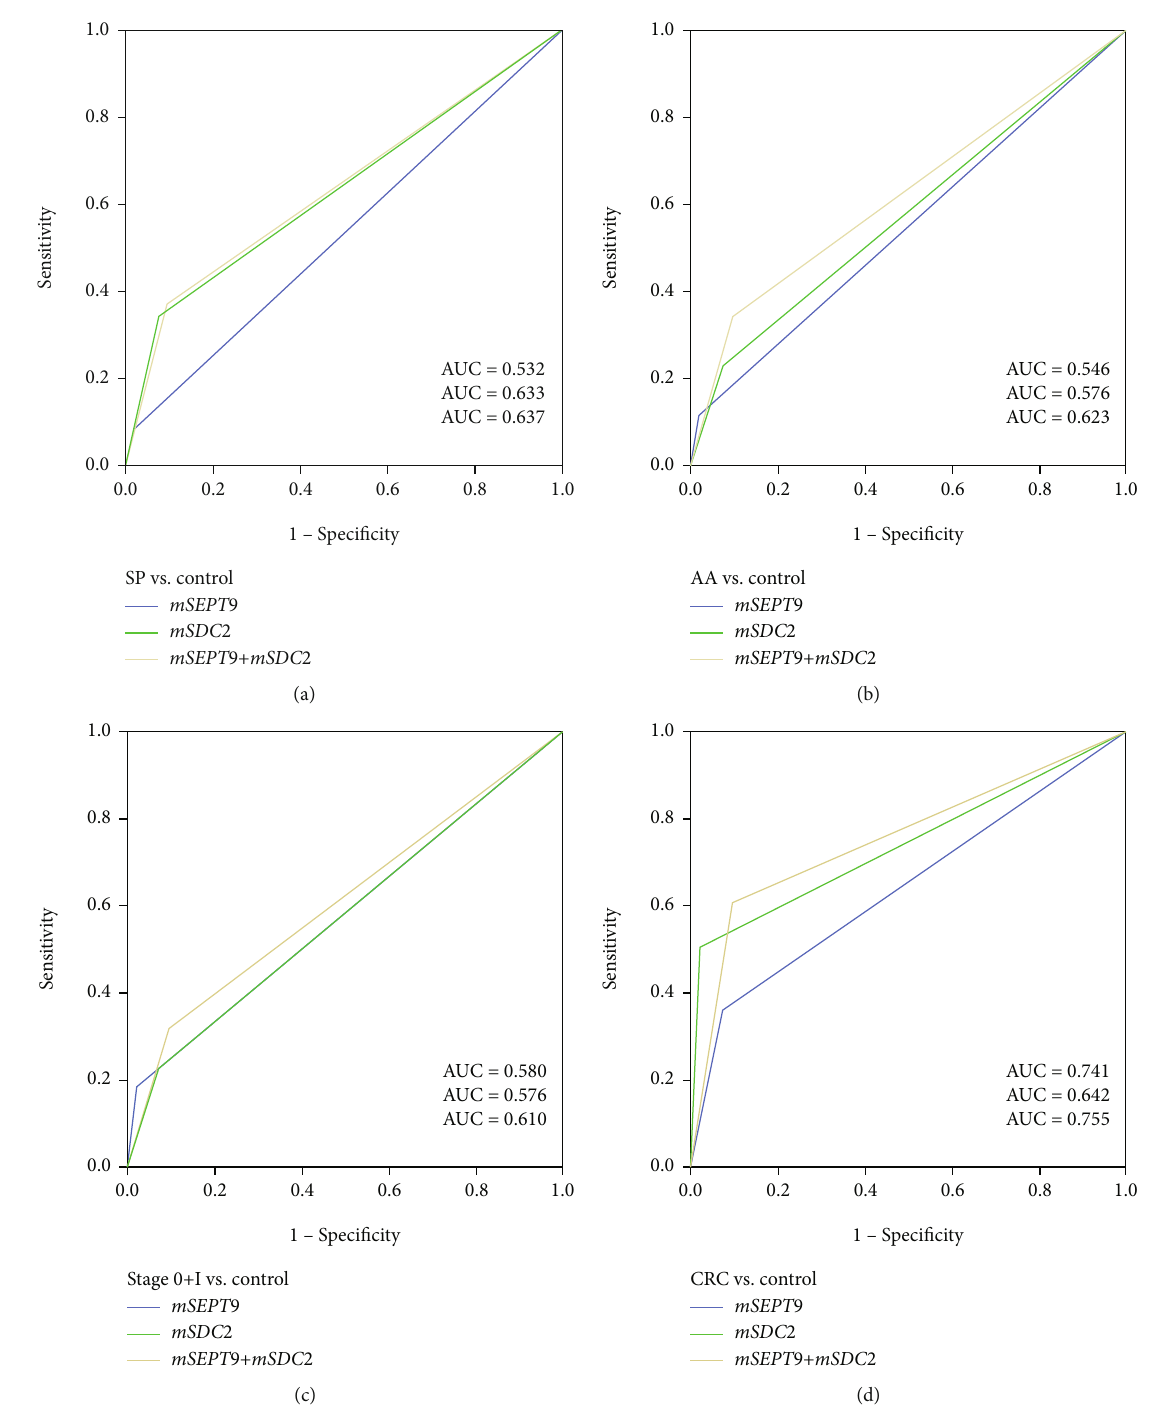
Figure 2: ROC curves for ColoDefense test in detecting (a) SP, (b) AA, (c) stage 0 and I CRC, and (d) all